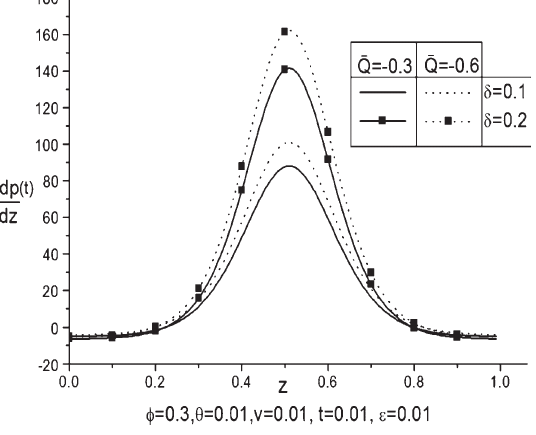
Fig. 3. Variation of pressure gradient over the length versus z with different values of flow rate Q with different δ